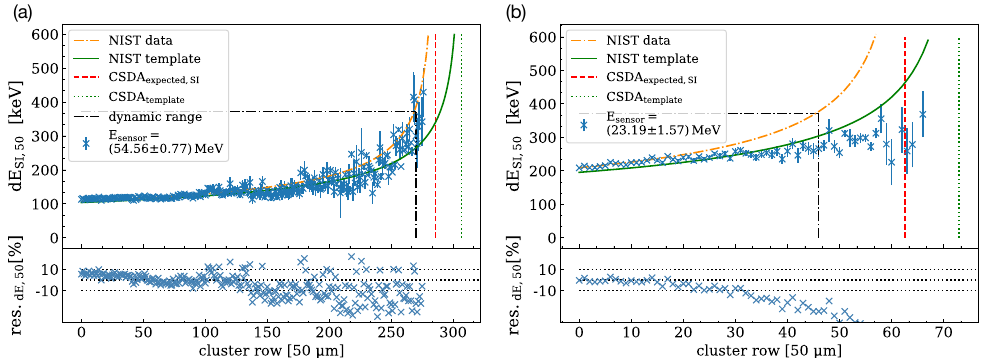
Figure 11. Mean deposited energy dE SI,50 per pixel along the proton tracks for ( a ) E sensor = ( 54.56 ± 0.77 ) MeV and ( b ) E sensor = ( 23.19 ± 1.57 ) MeV. The red line indicates the expected energy deposition according to the NIST database and the green line the energy deposition curve calculated by using the template method. The dynamic energy range of the detector, the expected CSDA range, and the measured CSDA range are highlighted as dotted lines. The relative difference between the expected energy deposition (orange curve) and the measured dE SI,50 is shown in the plots